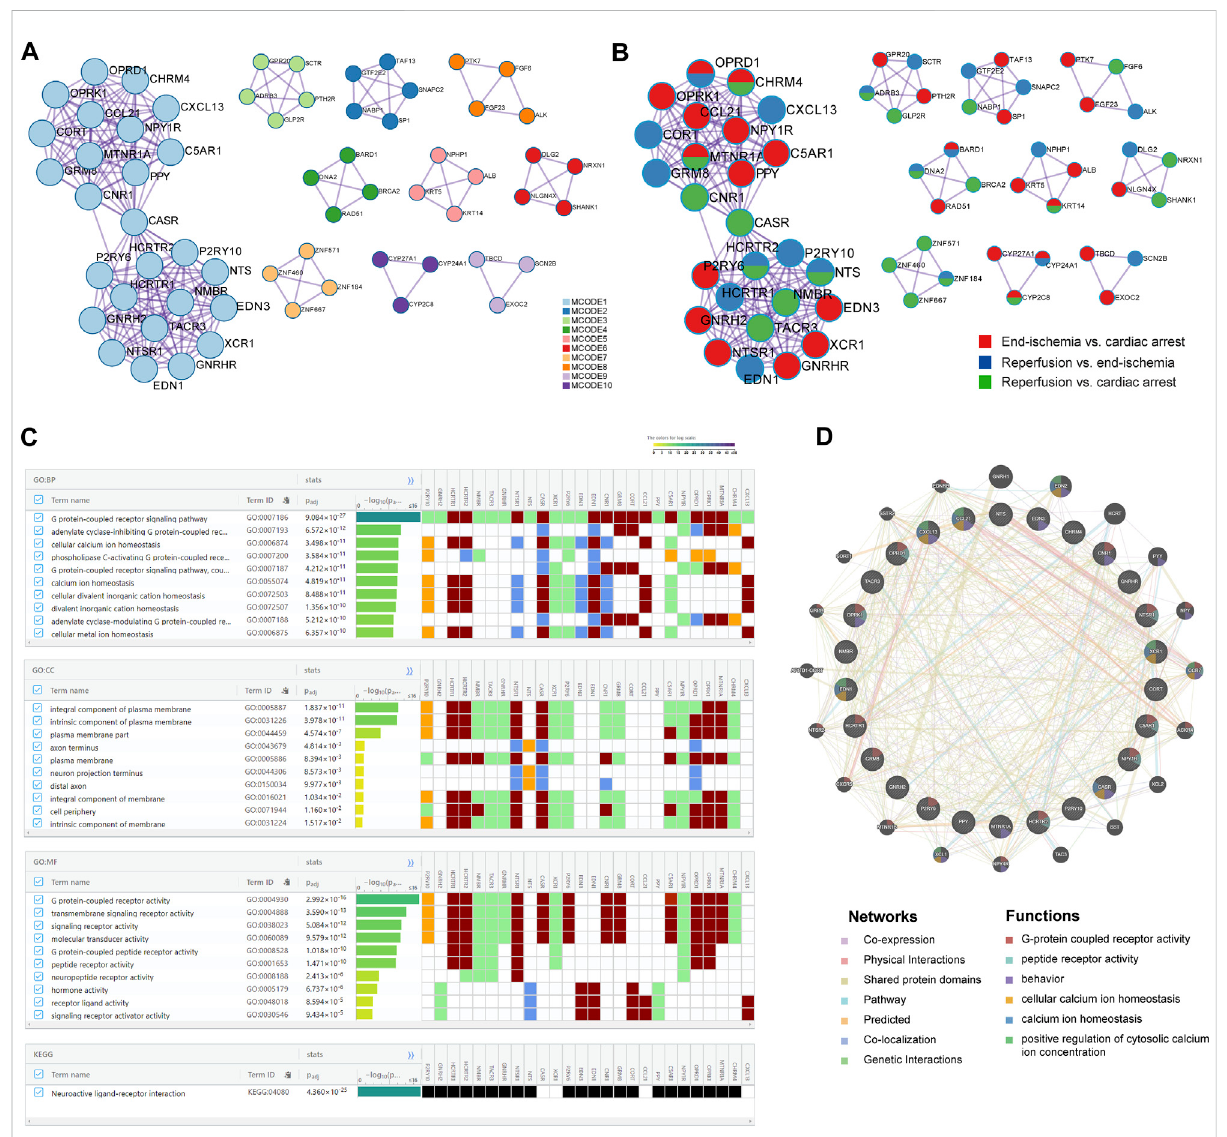
FIGURE 3 Key candidate genes and PPI network analysis. (A) Interactions among hub proteins in MCODE cluster 1. (B) Interactions among hub proteins, colored by identities of the proteins. (C) Top 10 enriched BP, CC, and MF terms, and enriched KEGG pathway. (D) Protein-protein interaction networks and